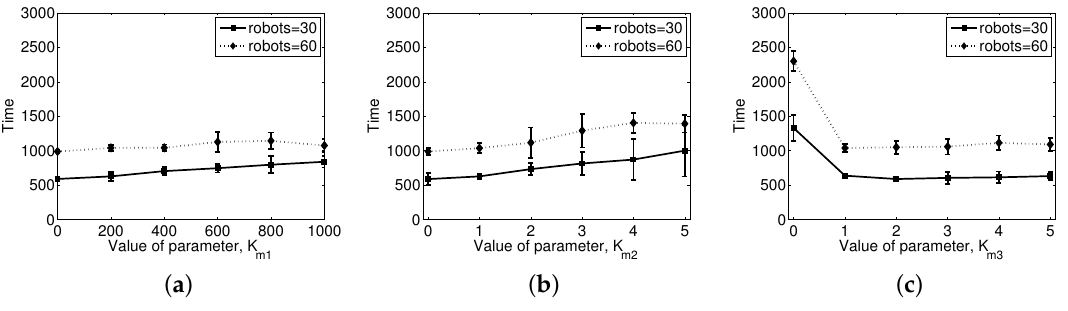
Figure 9. Time needed to reach the goal area, depending on changes in the parameters for forming a flock: ( a ) K m 1 for keeping distance from other sheep agents; ( b ) K m 2 for remaining close to the flock; and ( c ) K m 3 for velocity matching among sheep